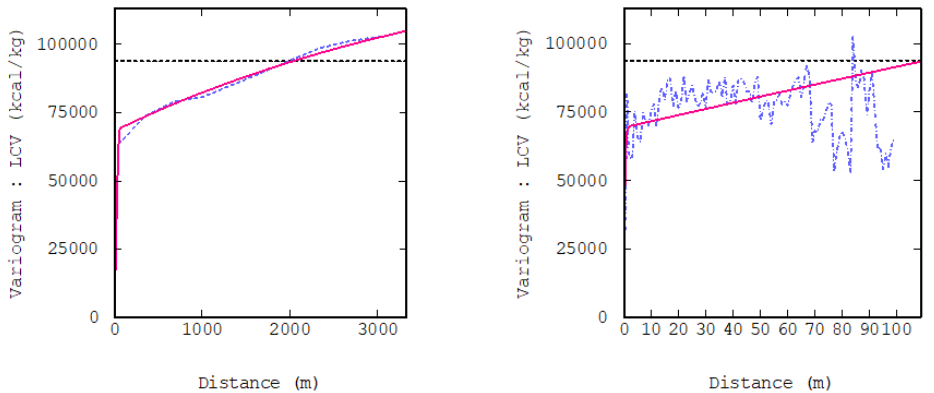
Figure 8. Experimental and fitted anisotropic variogram models for LCV. Dashed polylines (blue color) represent experimental variograms; thin dashed lines (black color) represent variance; continuous lines (red color) represent variogram models.